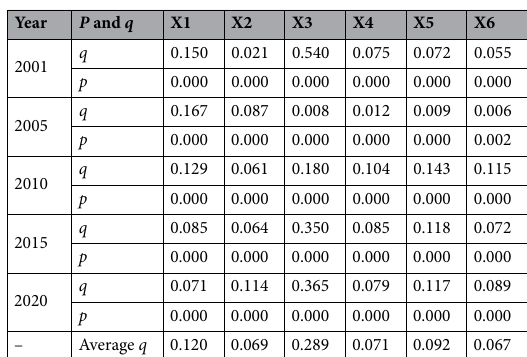
Table 7. Results of factor detection.